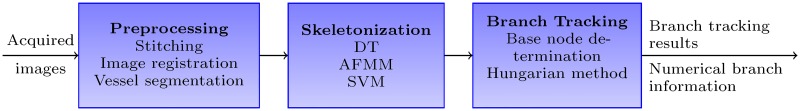
Diagram of the automated vessel formation tracking system.Preprocessing to extract binary vessel shapes. Skeletonization to obtain the connected skeleton segments with branch nodes and end nodes. Branch tracking to identify the routes for the main branches and associate the branches over time.